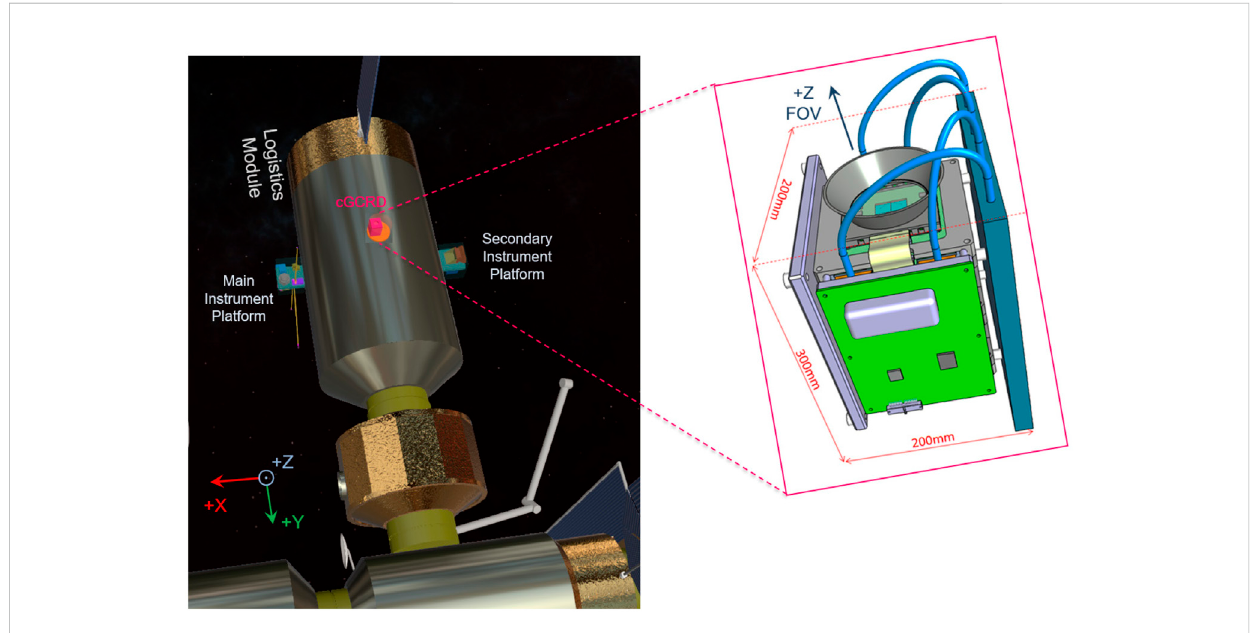
FIGURE 22 cGCRD mounted as a “ standalone ” instrument on the Logistics Module.